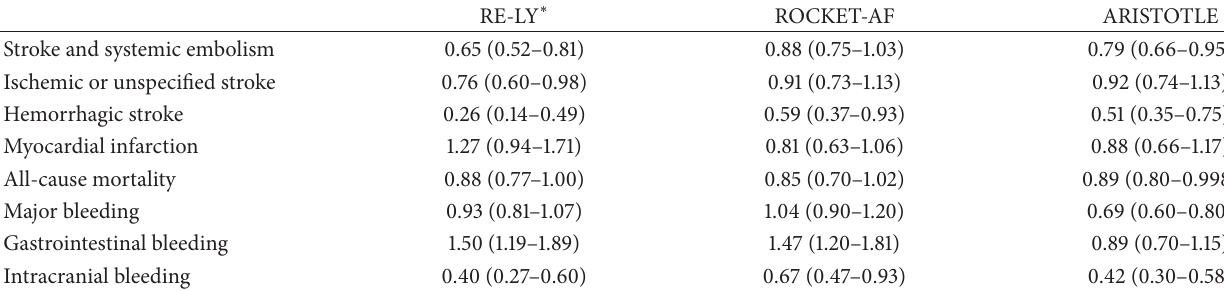
Table 2: Hazard ratios with 95% CI for novel oral anticoagulants compared with warfarin